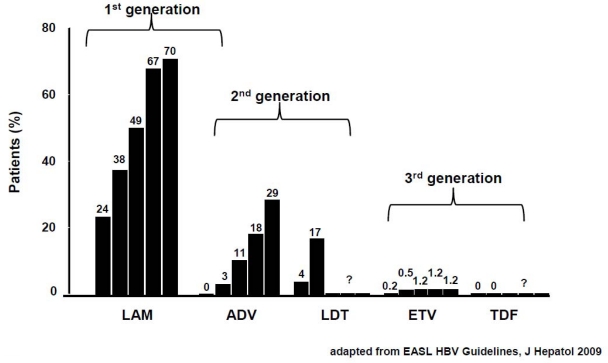
Incidence of resistance in NUC-naïve patients treated up to 5 years. Collation of currently available data – not from head-to-head studies.